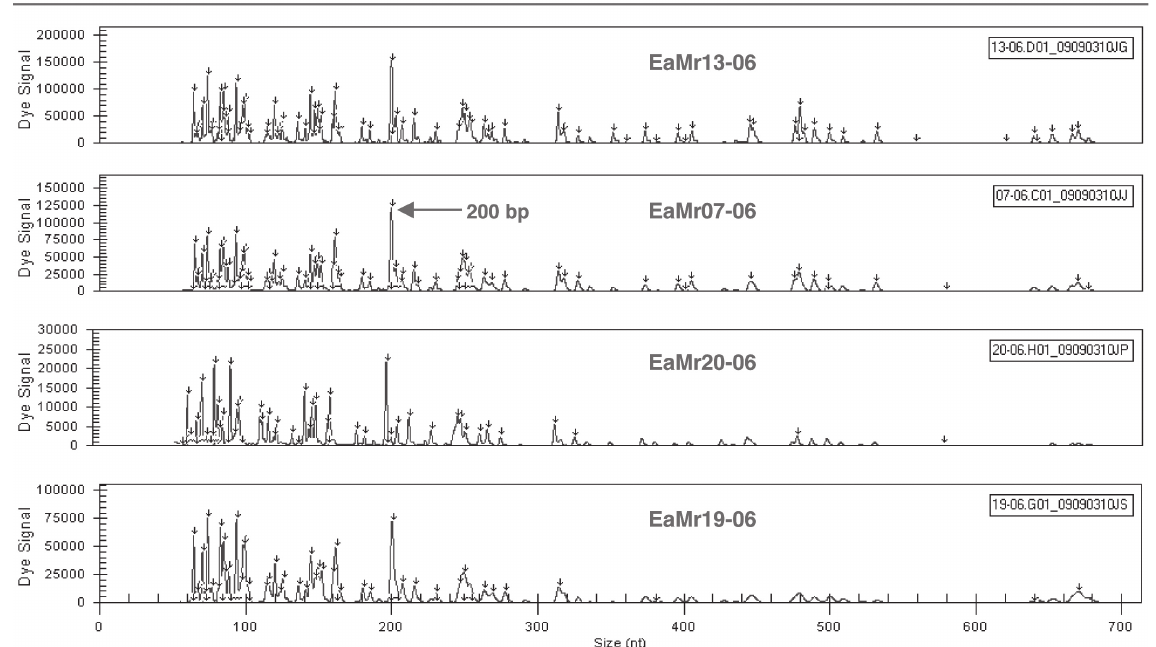
Figure 5. Electropherograms fAFLP after ampli fi cation using Eco RI+A plus Mse I+C